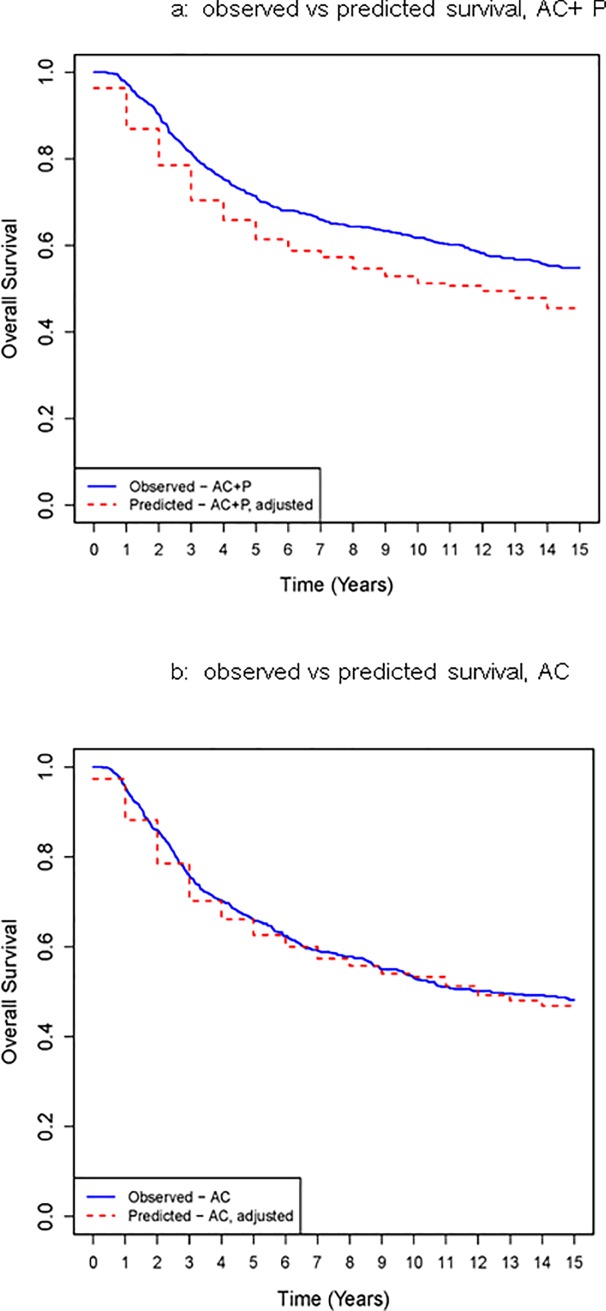
Predicted vs observed overall survival of CALGB patients receiving either AC+P (Fig 1A) or AC (Fig 1B).